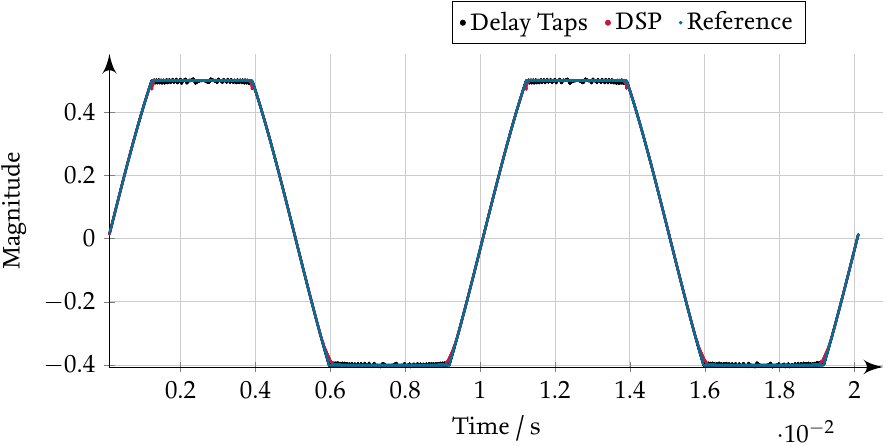
Figure 32. Sinc 3 filtered results for the limitation with a decimation rate of 20. Table 10. Resource consumption of the implementations for limiting on a FPGA. Implementation Logic